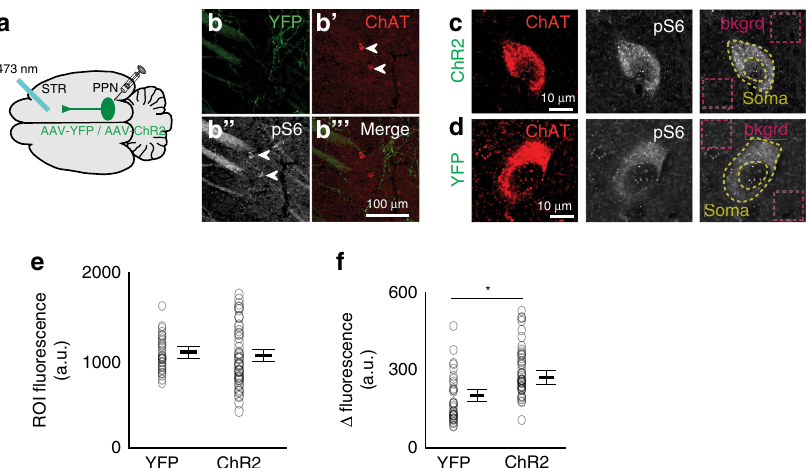
Fig. 4 Increase in the phosphorylation of serine 240 – 244 in CINs following activation of midbrain cholinergic axons. a Schematic of the experiment delivering optogenetic stimulation in striatal neurons of ChAT::Cre rats injected with AAV-DIO-ChR2-YFP ( fi ve rats) or AAV-DIO-YFP (controls; fi ve rats) in the midbrain. b Low magni fi cation confocal images showing the presence of transduced cholinergic axons from the midbrain in the vicinity of CINs b ′ that are co-expressing pSer240-244 (pS6) b ″ . c , d High magni fi cation confocal images showing pSer240-244 intensity in CINs following blue laser stimulation of ChR2/YFP-transduced c or YFP-transduced ( d , controls) cholinergic midbrain axons in the striatum. No differences were observed in the expression of pSer240-244 signal in the background ( e ; unpaired two-sided t -test, P = 0.8033), whereas a signi fi cant difference in fl uorescence was found between the background and the soma ( f ; 165 neurons, unpaired two-sided t -test, P = 0.00001; see “ Methods ” ) following laser stimulation of YFP or ChR2-YFP-expressing cholinergic midbrain axons in the striatum. Individual data points and mean ± SEM are shown. * P <